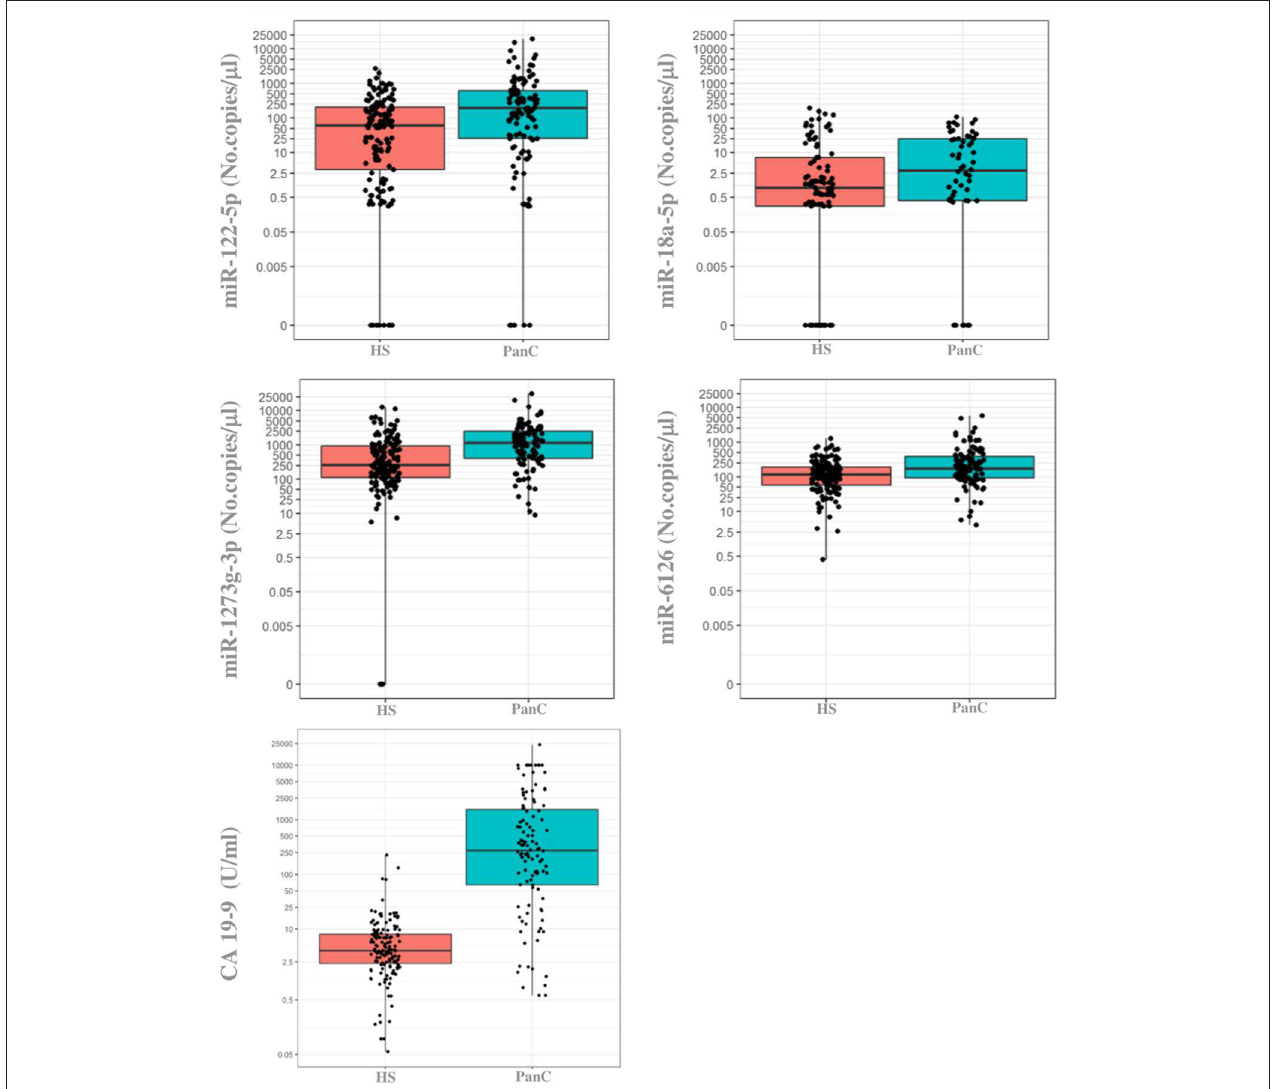
FIGURE 3 | Boxplots of the absolute quantification of circulating levels of miRNAs and CA 19-9 in healthy subjects and in patients with pancreatic cancer. The ends of each box are the upper and lower quartiles, so the box spans the interquartile range (IQR), whereas the median is marked by a horizontal black line inside the box. The whiskers are the two lines outside the box that extend to the highest and lowest plotted observations (black dots). Values of both miRNAs (no.copies/ µ l) and CA 19-9 (U/ml) are reported in log scale (y-axis). PanC, pancreatic cancer; HS, Healthy